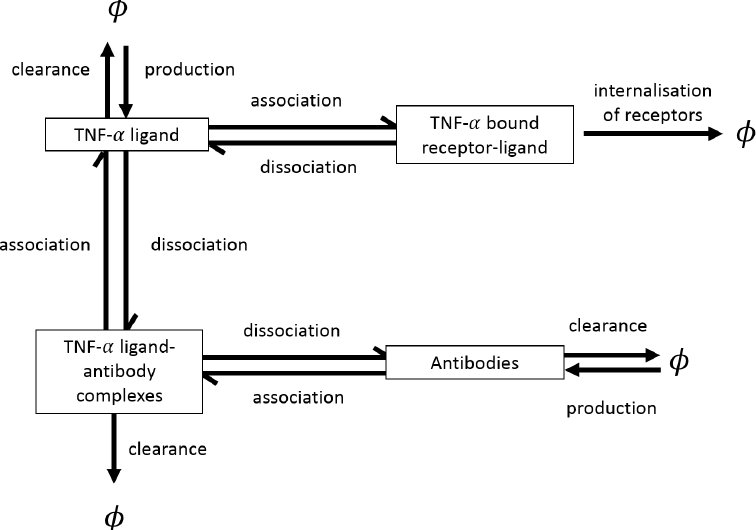
Figure 4. Schematic describing the chemicals, receptors and processes included in model described in [70]. The models considers four variables; antibodies, TNF- α , bound TNF- α and antibody-TNF- α complexes, along with their interactions with each other. Note that, here φ represents objects outwith or removed from the system.